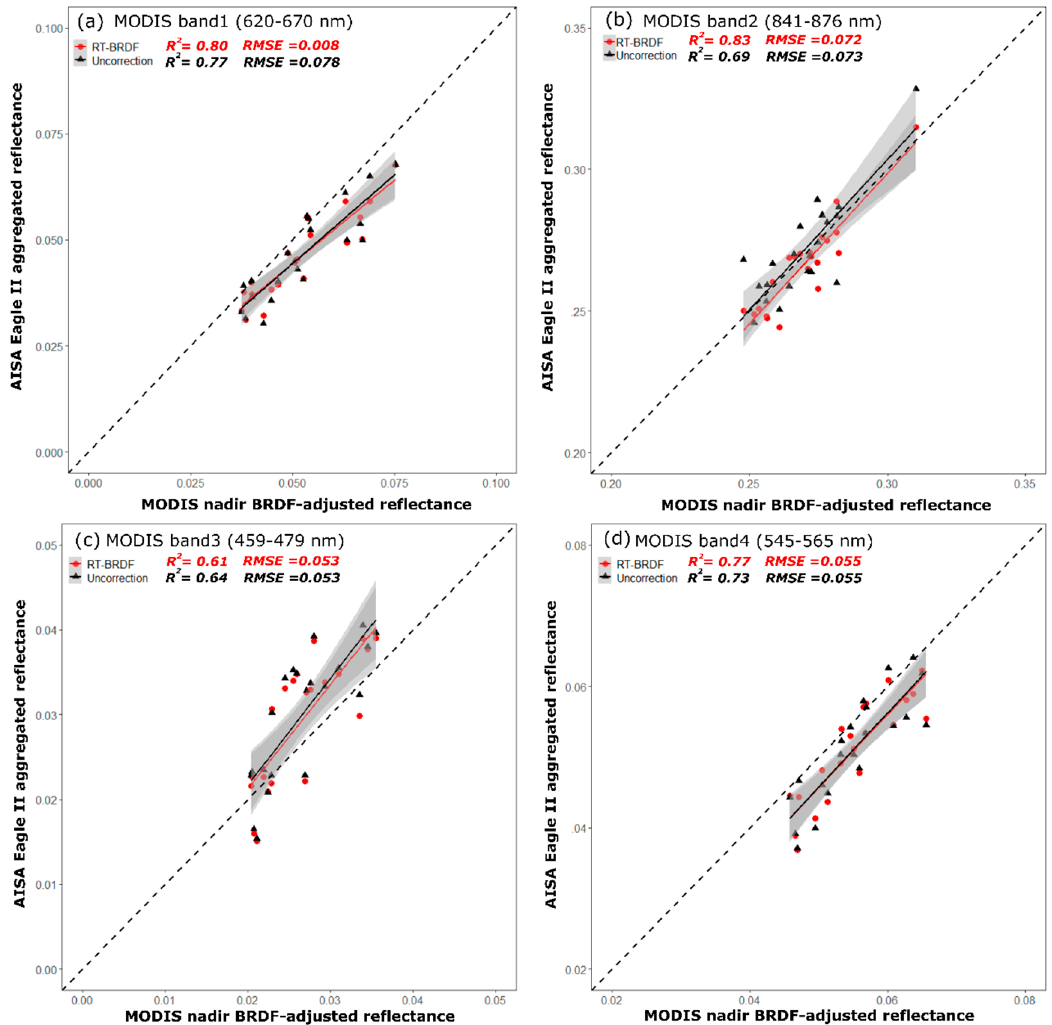
Figure 13. Comparison between AISA Eagle II aggregated reflectance and MODIS nadir BRDF-adjusted reflectance corresponding band1-4 ( a – d ), respectively. The best linear fit is in solid red / black, and the 1:1 line is in dashed black.